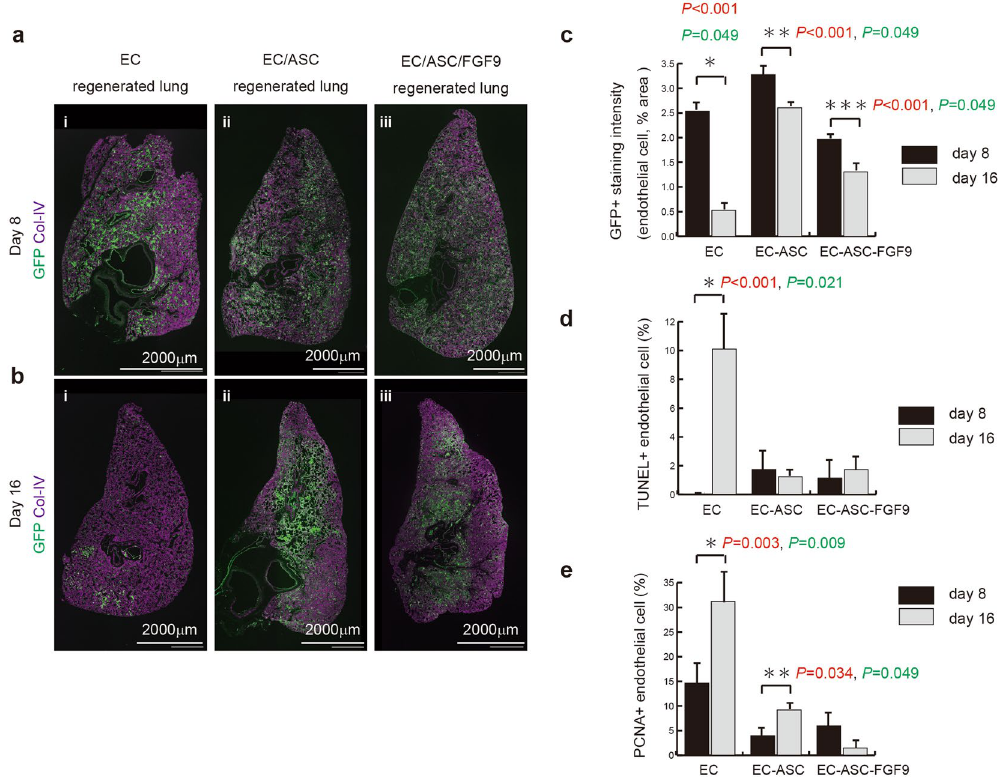
Figure 6. ASCs facilitate ex vivo EC survival in regenerated lungs. ( a, b ) Grouped immunofluorescence images of whole EC- (i), EC–ASC- (ii) and EC–ASC–FGF9- (iii) regenerated lungs showing expression of eGFP-ECs (green) and collagen IV (purple) at days 8 ( a ) and 16 ( b ) of culture. Gross distribution of eGFP-ECs was similar in each group at day 8 ( a ), and the majority of eGFP-ECs had disappeared by day 16 in the EC group ( b, i ). Scale bars: 2000 μ m. ( c ) Bar graph showing expression of eGFP staining intensity normalized to collagen IV matrix at days 8 and 16 of culture. ( d ) Bar graph showing the rate of TUNEL + ECs relative to total ECs within a unit area of the regenerated lungs (at days 8 and 16 of culture). ( e ) Bar graph showing the rate of PCNA + ECs relative to total ECs within a unit area of the regenerated lungs (at days 8 and 16 of culture). The p-values by the Student’s t-test and Mann–Whitney U test are shown in red and green, respectively. All values are means ± SD of three independent